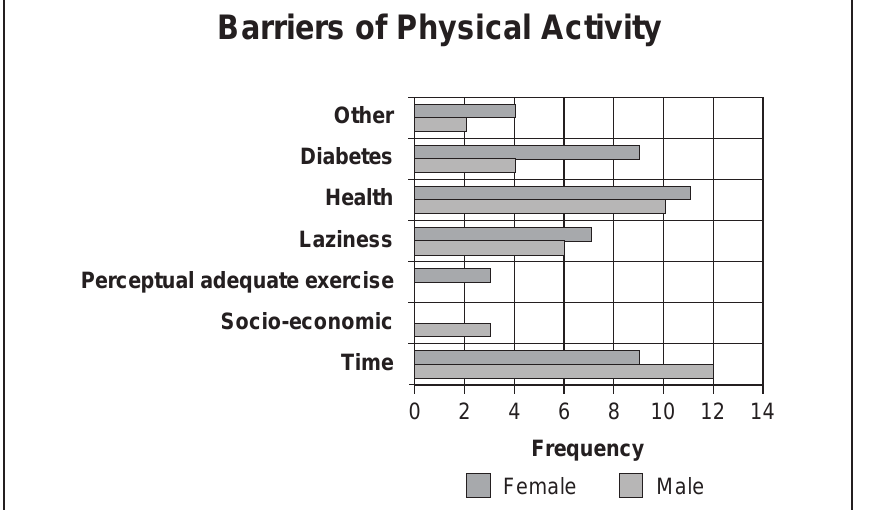
Figure 4: Barriers of physical activity.